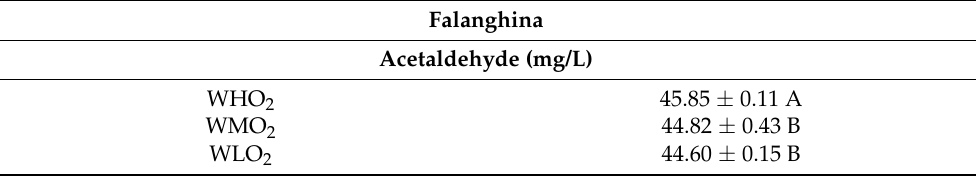
Table 2. Evolution of acetaldehyde after 11 months of aging of treated Falanghina white